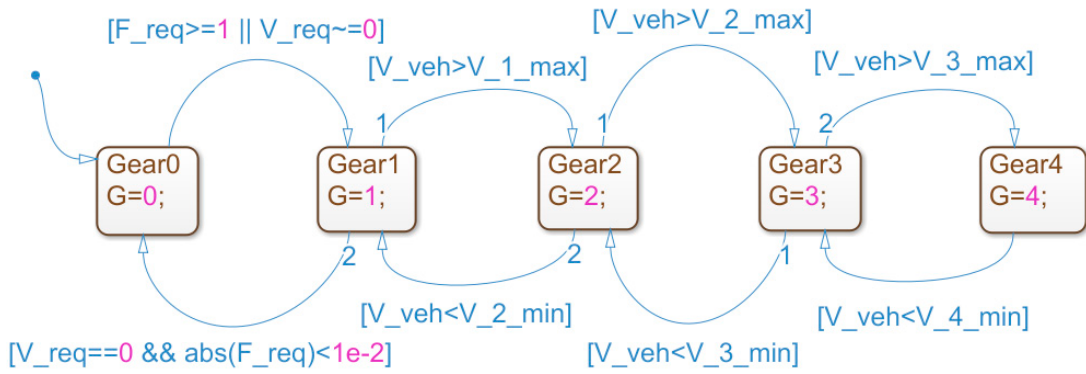
Figure 14. The gear determination control.